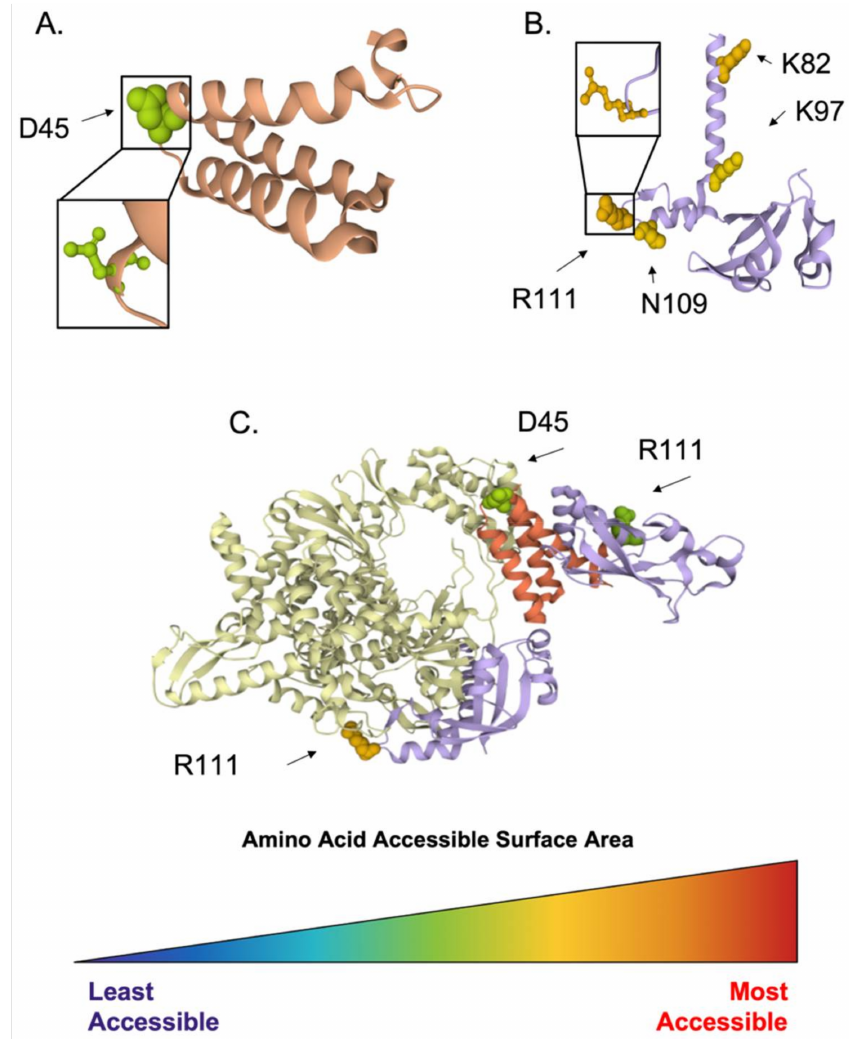
Figure 6. Conserved and accessible amino acids of CoV replicase. Identified conserved and accessible residues of interest within coronavirus Nsp7 and Nsp8 highlighted with molecular surface repre- sentation and colored by amino acid accessible surface area (ASA), ranging from the least accessible (dark blue) to the most accessible (red) in their respective monomer crystal structures ( A , B ) and in complex with the viral RNA-dependent RNA polymerase (Nsp12) ( C ). ( A ) Nsp7 (PDB ID: 6NUR) with the most conserved and exposed amino acid highlighted, D45. ( B ) Four highly conserved and exposed residues within the Nsp8 structure are highlighted, K82, K97, N109, and R111, with magnification of the most accessible residue, R111. ( C ) The most conserved and accessible residue of Nsp7 (red-orange) and Nsp8 (purple) highlighted in the replicase holoenzyme (PDB ID: 6NUR), complexed with Nsp12